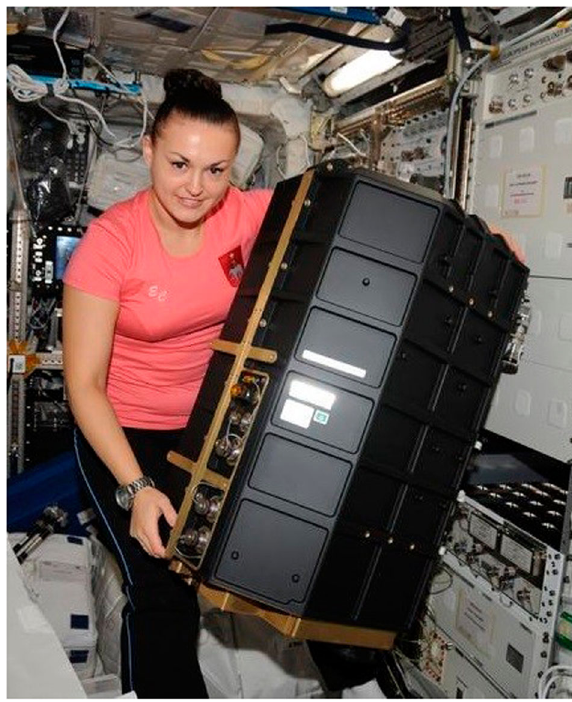
Fig. 4 The PK-4 container onboard the ISS. PK-4 was installed in the Columbus module by Cosmonaut Elena Serova in November 2014 (Photo: DLR, CC BY-NC-ND 3.0).